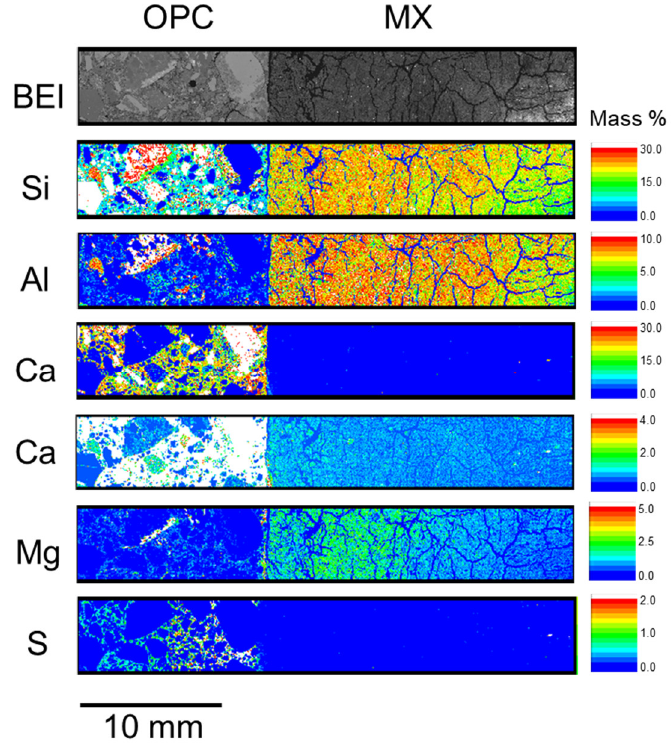
Figure A3. Elemental distribution of OPC-MX_4.9 y (BCI-15).